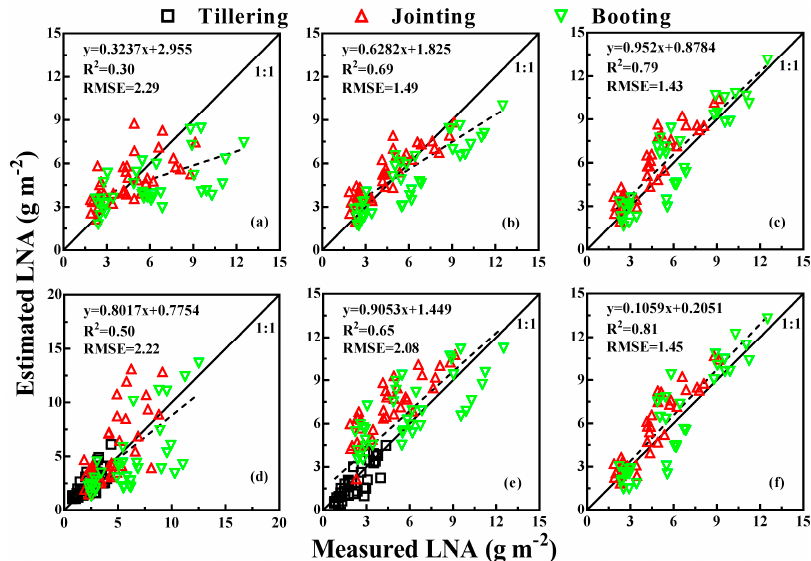
Figure 7. The 1:1 relationship between the estimated and measured leaf N accumulation (LNA, g m − 2 ) in rice based on NGRDI-MCA ( a ), GNDVI-MCA ( b ), CI red edge ( c ), NGRDI-RGB ( d ), GNDVI-CIR ( e ), and DATT ( f ). Only RGB and CIR images have tillering data. The solid line indicates the 1:1 line and the dashed line indicates the regression line.